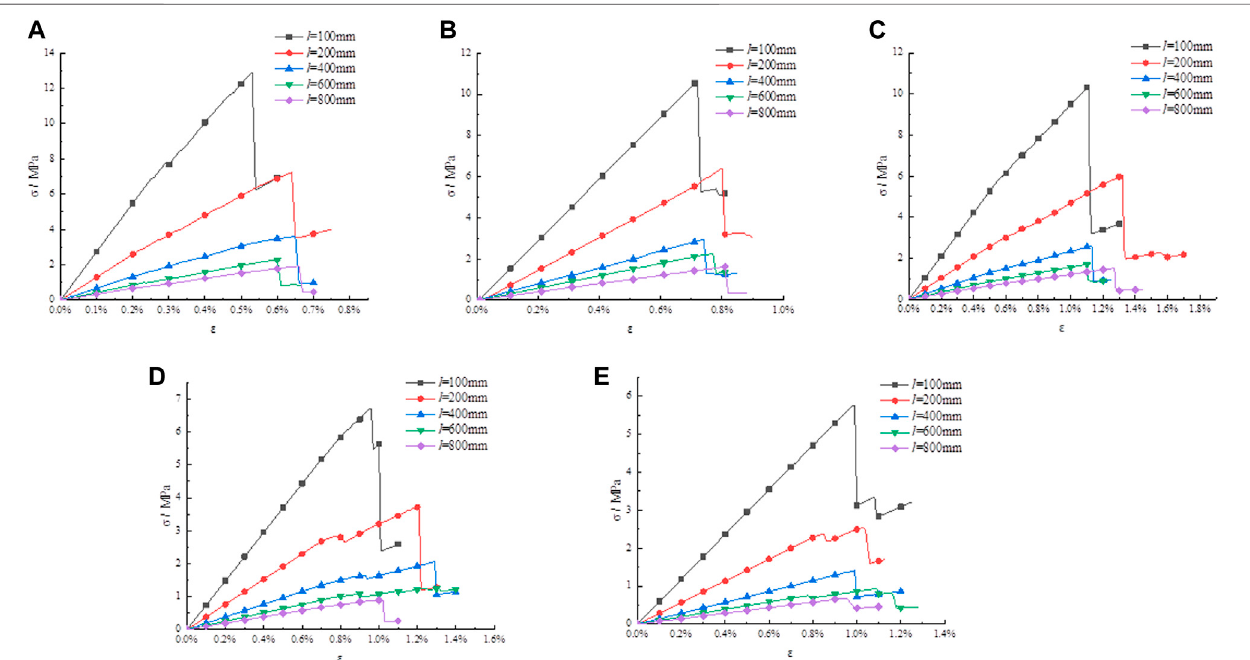
FIGURE 1 | Stress – strain curves with different numbers of parallel-joint. (A) l = 100 mm, (B) l = 200 mm, (C) l = 400 mm, (D) l = 600 mm, (E) l = 800 mm.